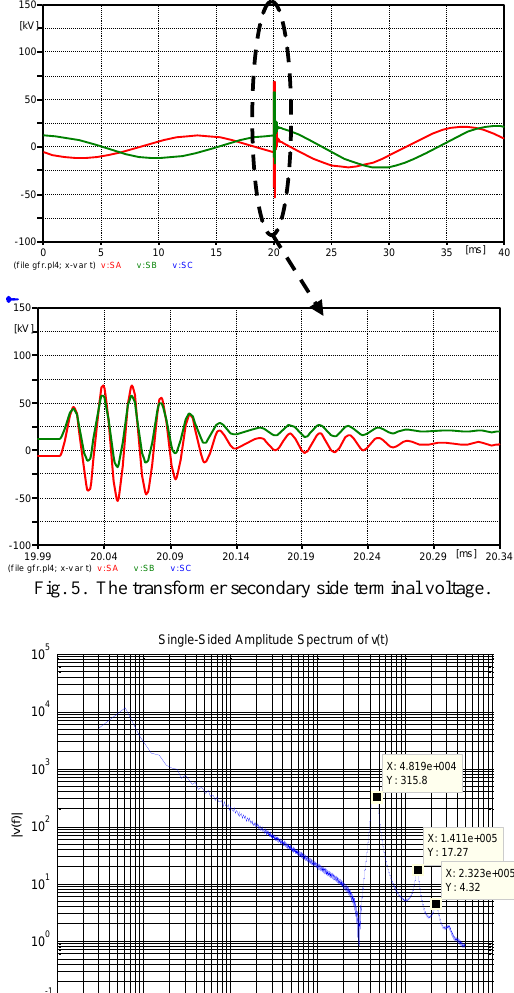
Fig. 6. FFT analysis for phase-c secondary voltage waveform.